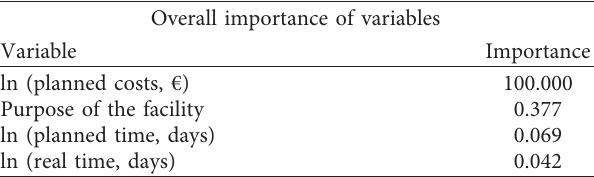
Table 3: Importance of the variables.